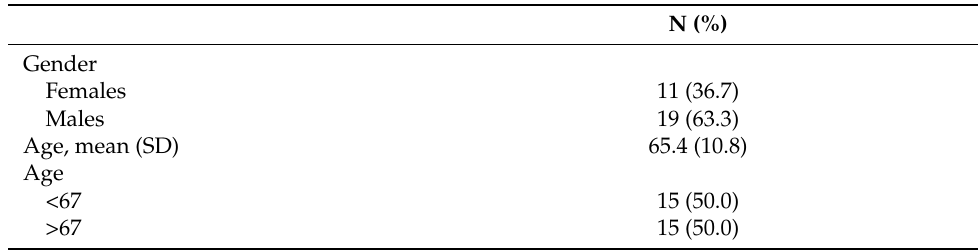
Table 1. Age and gender of the participants.